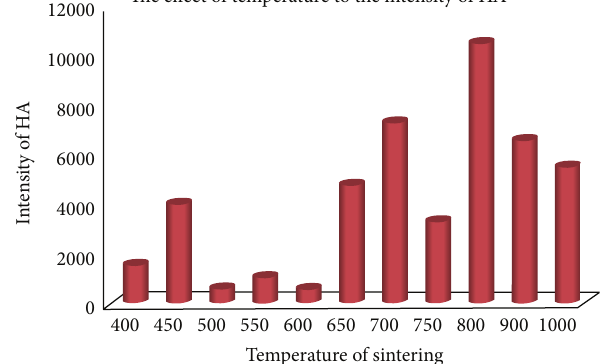
Figure 4: The influence of sintering temperatures on the formation of hydroxyapatite phase.